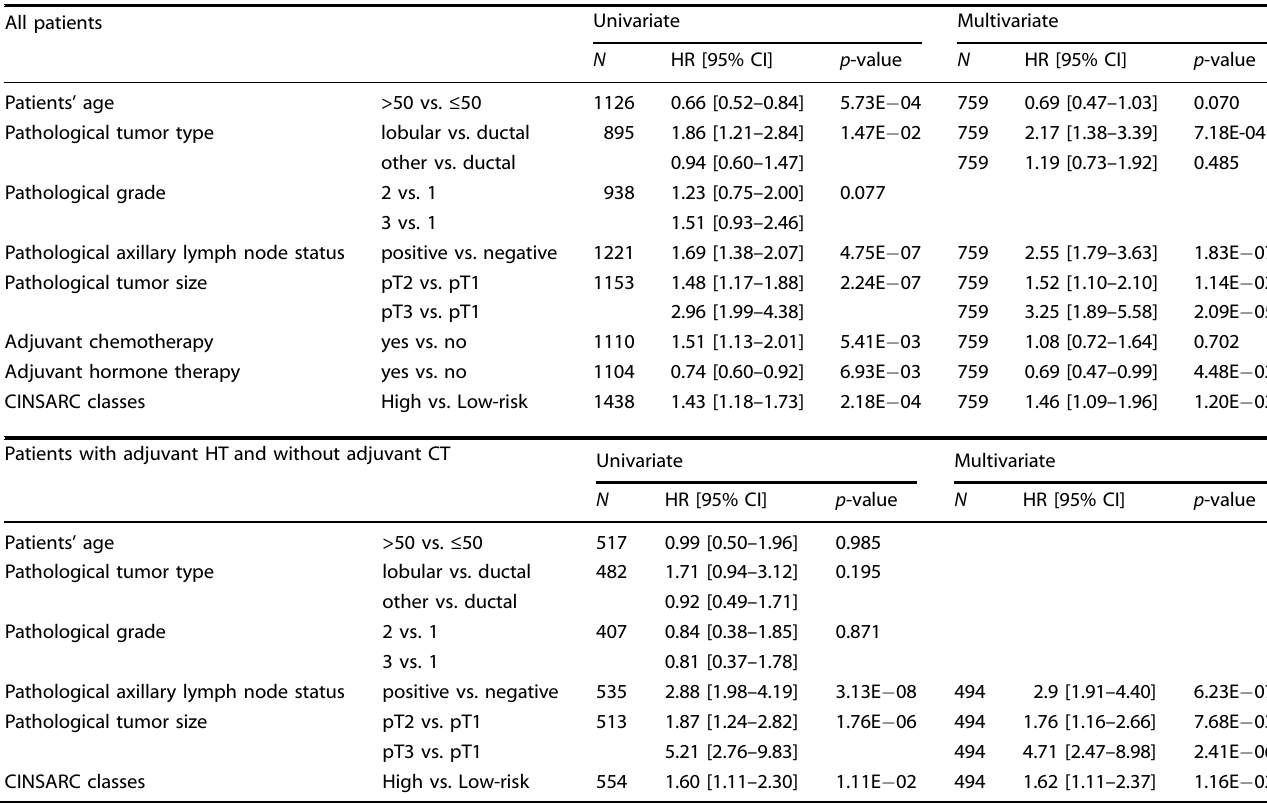
Table 3. Univariate and multivariate Cox regression analyses for DFS in Luminal B breast cancer